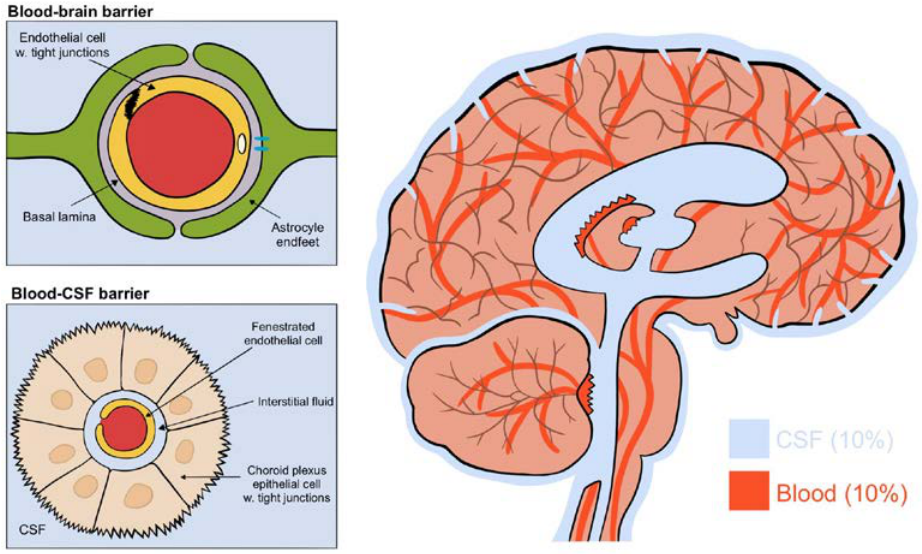
Figure 2. (Figure illustrated by Jessamyn Camille Reddy, adapted from; [1] p. 22, permission obtained) The four fluid compartments of the brain, separated by the blood–brain barrier or the blood–CSF barrier. The blood–brain barrier is situated wherever the vasculature reaches; the blood–CSF barrier is situated only in the choroid plexus and allows the passage of macromolecules.